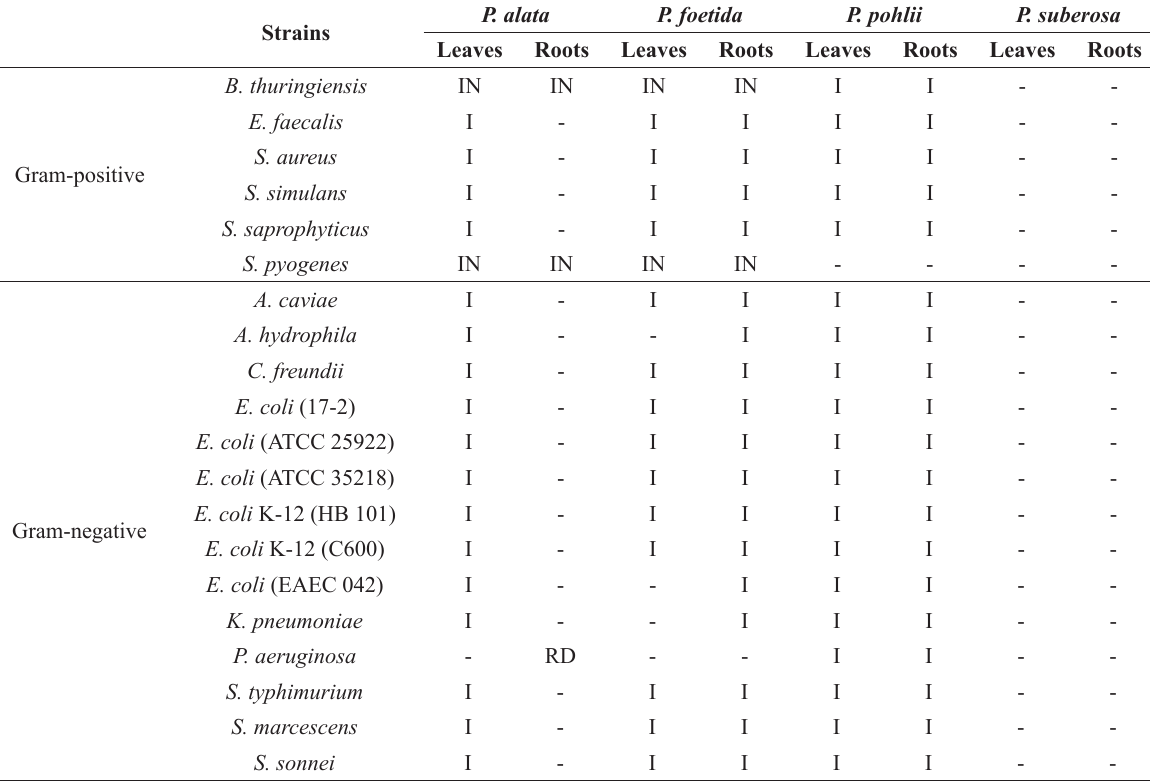
Evaluation of the antibacterial activity of crude extracts (1000 µg.mL -1 ) from in vitro -derived materials of four Passiflora species using the macrodilution